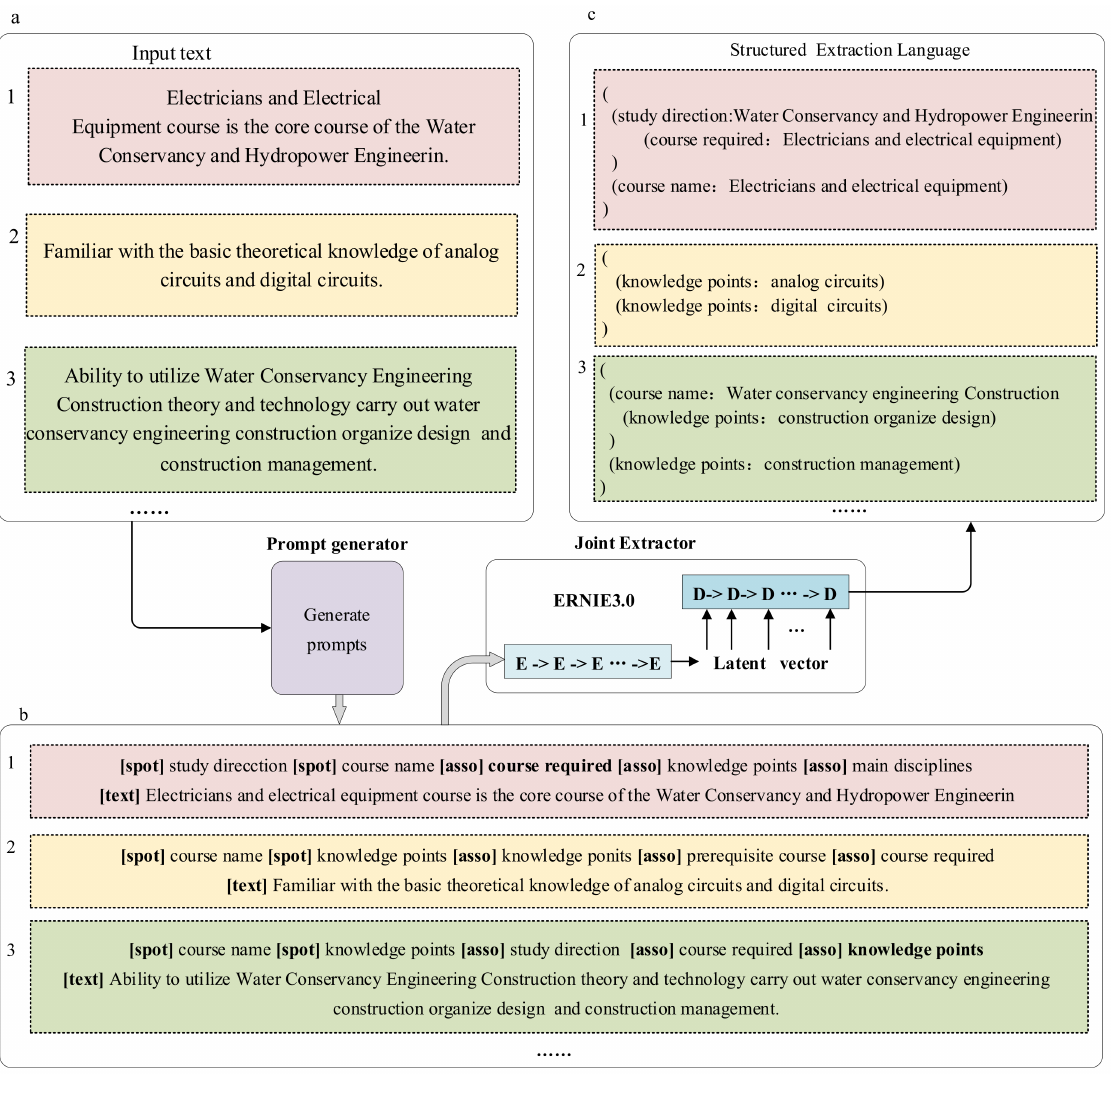
Figure 4. Overall Framework of WDERJE. Part ( a ) is the input text; Part ( b ) is the sequence of prompts; Part ( c ) is the sequence of